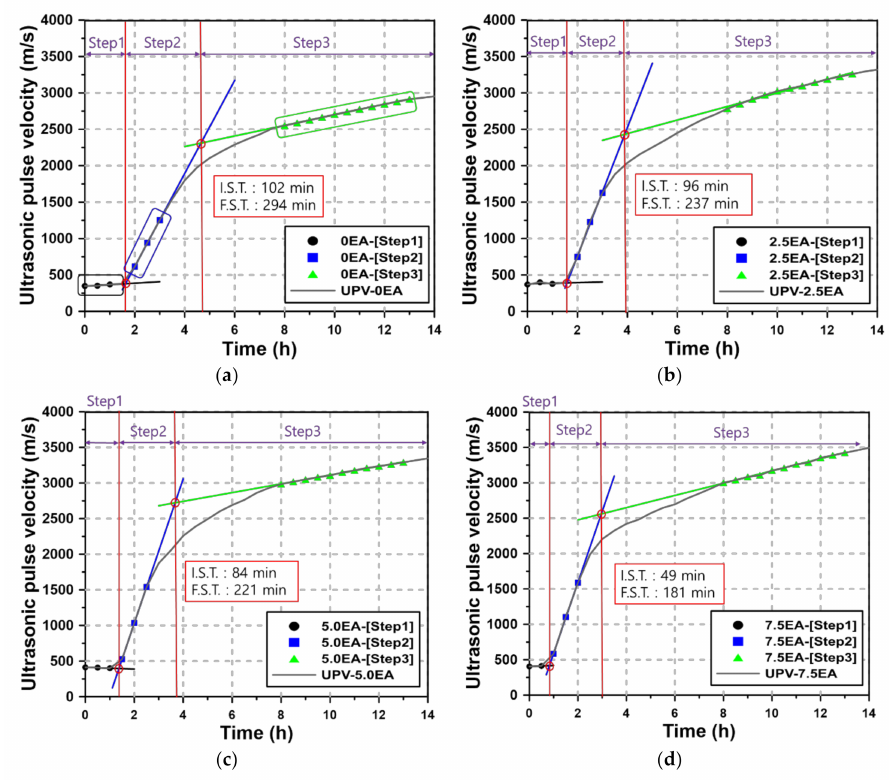
Figure 4. UPV curves of AAM mortar: ( a ) 0 EA, ( b ) 2.5 EA, ( c ) 5.0 EA, ( d ) 7.5 EA.